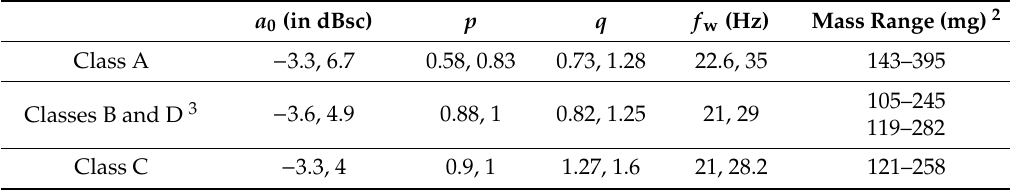
Table 2. Class boundaries for large insects and calculated mass range 1 based on the size distribution.